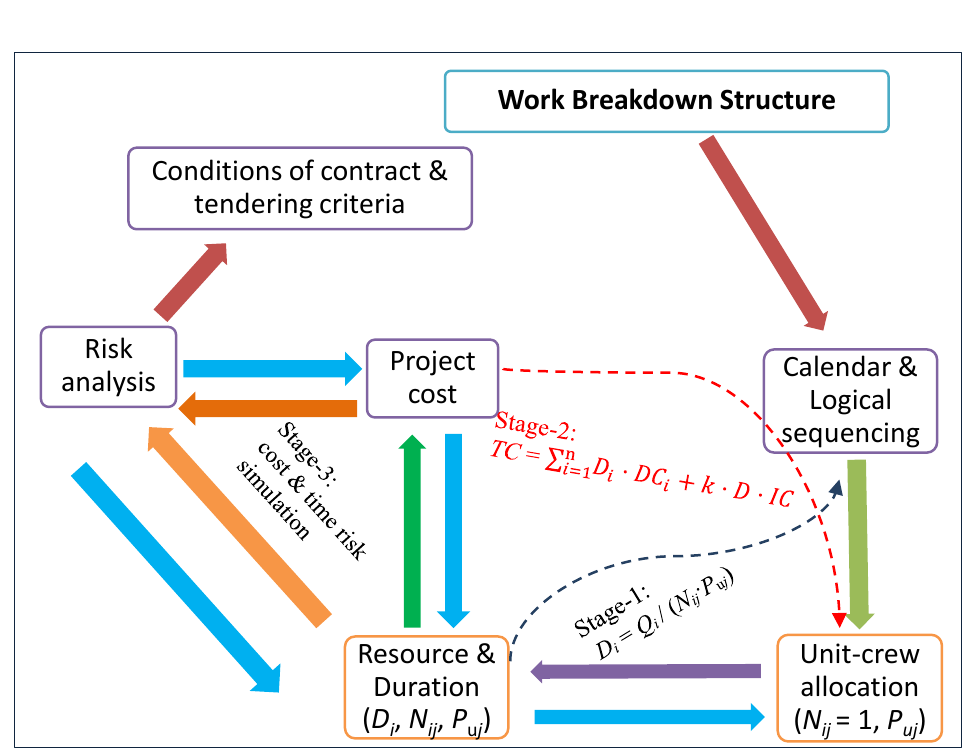
Fig. 3. Framework for construction project scheduling at the planning phase (developed by the author).